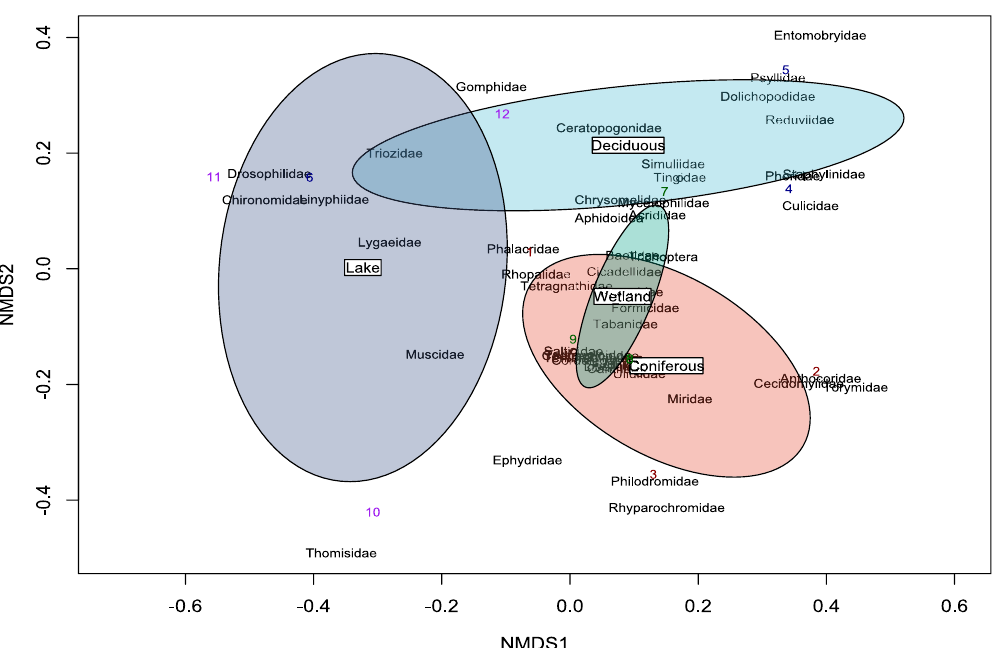
Figure 6. Non-metric multidimensional scaling (NMDS) of arthropod taxa observed in coniferous (red), deciduous (light blue), wetland (green), and lake (dark blue) habitats. Numbers represent sites within habitats (sites 1, 2, and 3 are coniferous, sites 4, 5, and 6 and deciduous, sites 7, 8, and 9 are wetlands, and sites 10, 11, and 12 are lakes). Points closer to each other are more similar in community composition than points farther